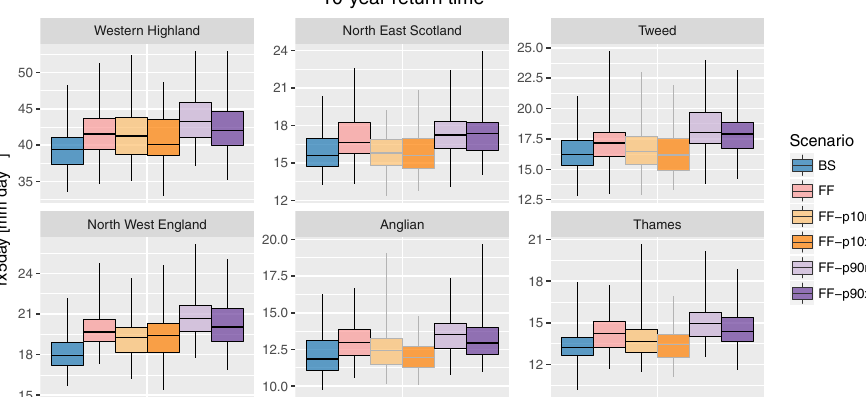
Figure 16. Distribution of return values of the 10-year event for rx5day (box plot) for each region (panel) and scenario (colour), using raw precipitation data (i.e. not bias corrected). Whiskers display the range from individual time series. Grey boxes for future scenarios indicate statistically non-significant change in mean return value with respect to the baseline at the 95% level according to a two-sided T test. See Fig. S22 for the plots for all regions; the corresponding figure for the near-future time slices is shown in Fig.